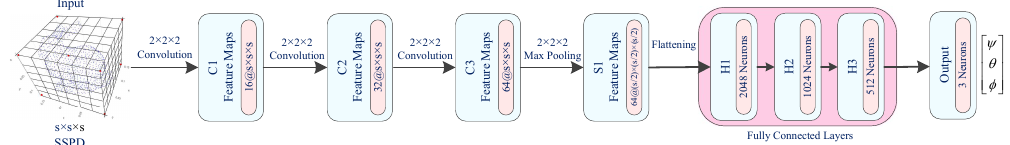
Figure 8. A 3-D convolutional neural network (CNN) architecture for the rough registration.